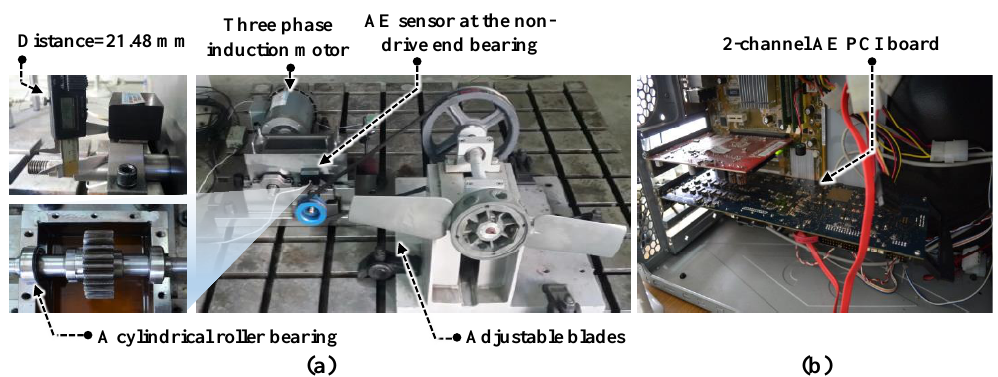
Figure 2. ( a ) Experimental setup to record fault data and ( b ) PCI-2 AE (Peripheral Component Interconnect-2 Acoustic Emission) (data